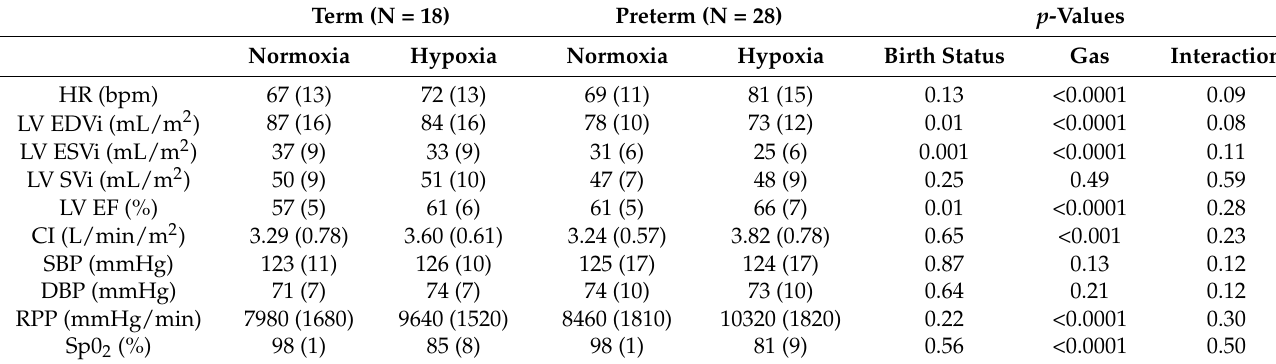
Table 2. Cardiac MRI measurements and vital signs.